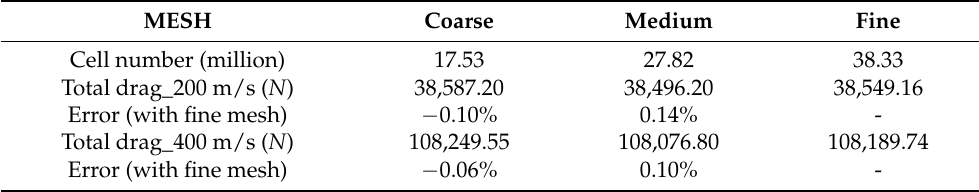
Table 1. Spatial resolution and drag for coarse, medium, and fine grids.